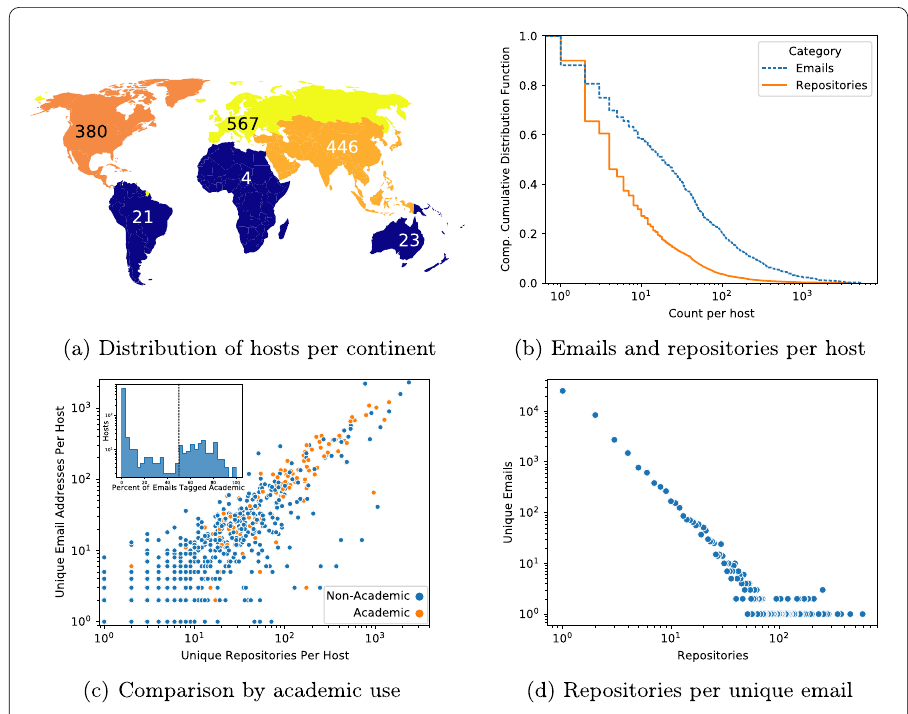
Figure 1 The penumbra of open source. ( a ) Geographic distribution of hosts and unique email addresses (in parentheses) in our Penumbra sample. ( b ) Distributions of emails per host and repositories per host. ( c ) Distribution of unique emails per repositories. ( d ) Correlation between repositories and emails per host. We see that the number of repositories and email addresses generally correlate, with some outlying hosts with many more repositories than emails. Academic hosts follow the same general trend, except that they tend to be larger than many non-academic hosts. (inset) Hosts are classified as “academic” if over 50 percent of their email addresses end in .edu or come from a manually identified academic domain